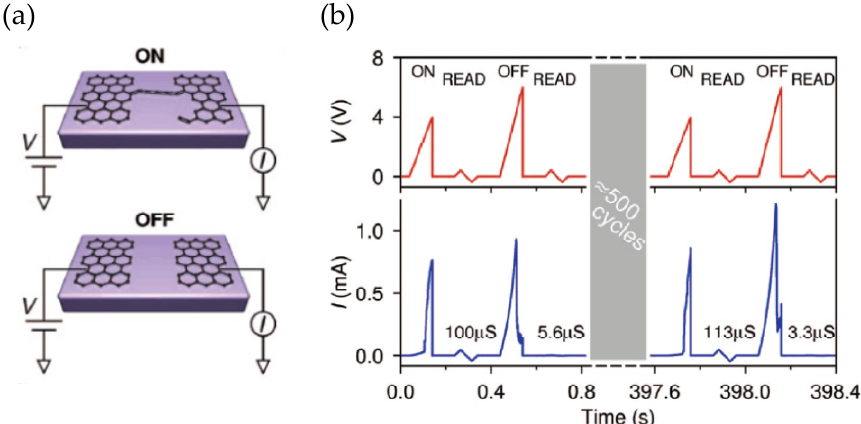
Figure 3. ( a ) Proposed schematic atomic configurations in the on and off states of transistor ‐ type memory. ( b ) Repeatable programming over hundreds of cycles [119] .